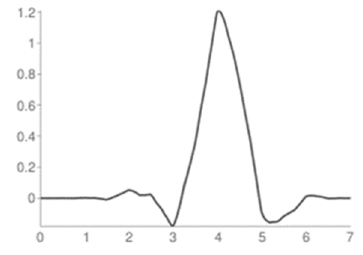
Figure 12. Wavelet Symlets 4 (sym4).